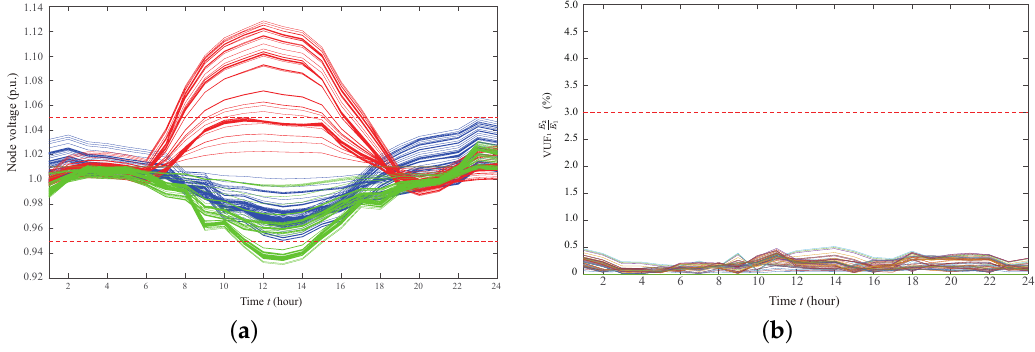
Figure 22. Minimized VUF but voltage imbalance remaining case: ( a ) voltage profiles and ( b ) VUF 1